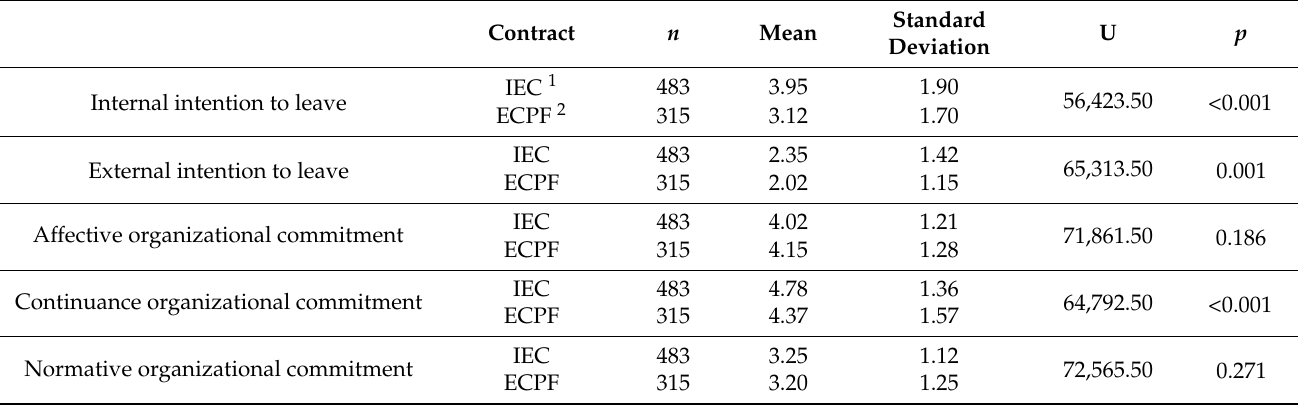
Table 3. Results of the Mann–Whitney test on the intention to leave and organizational commitment according to the contractual